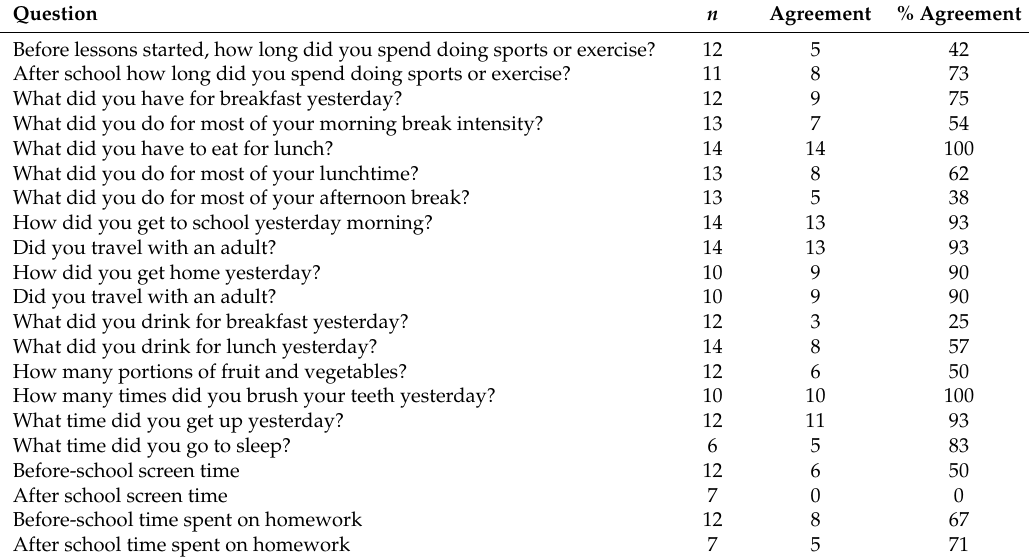
Table 2. Percentage agreement for between-measure agreement of self-reports compared to the autographer for all 21